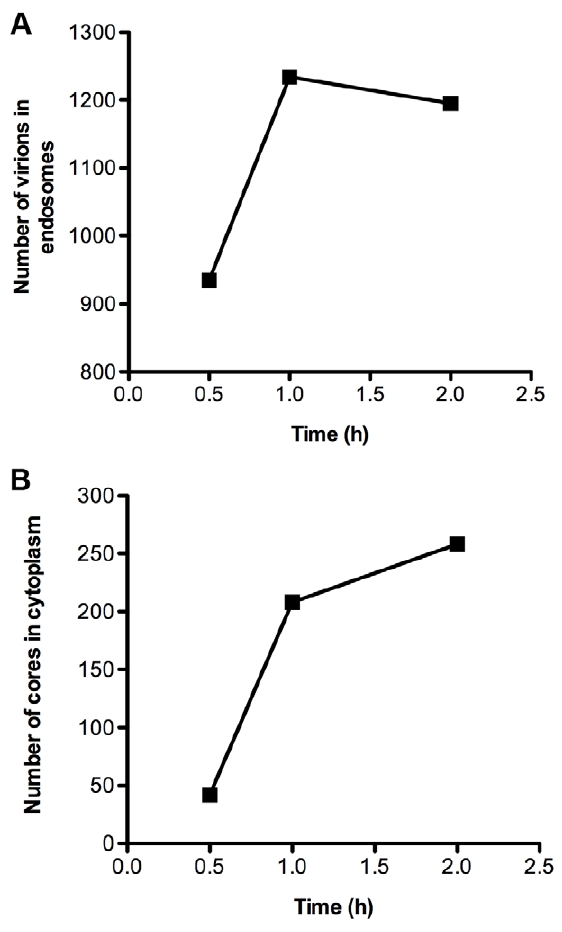
Figure 5. Quantification of virions in endosomes and cores in cytoplasm. Data are from the same experiment used to obtain images in Fig. 4. The numbers of virus particles were counted in single sections of 90 different cells and the totals plotted: A ) MVs in vesicles; B ) cores in cytoplasm.